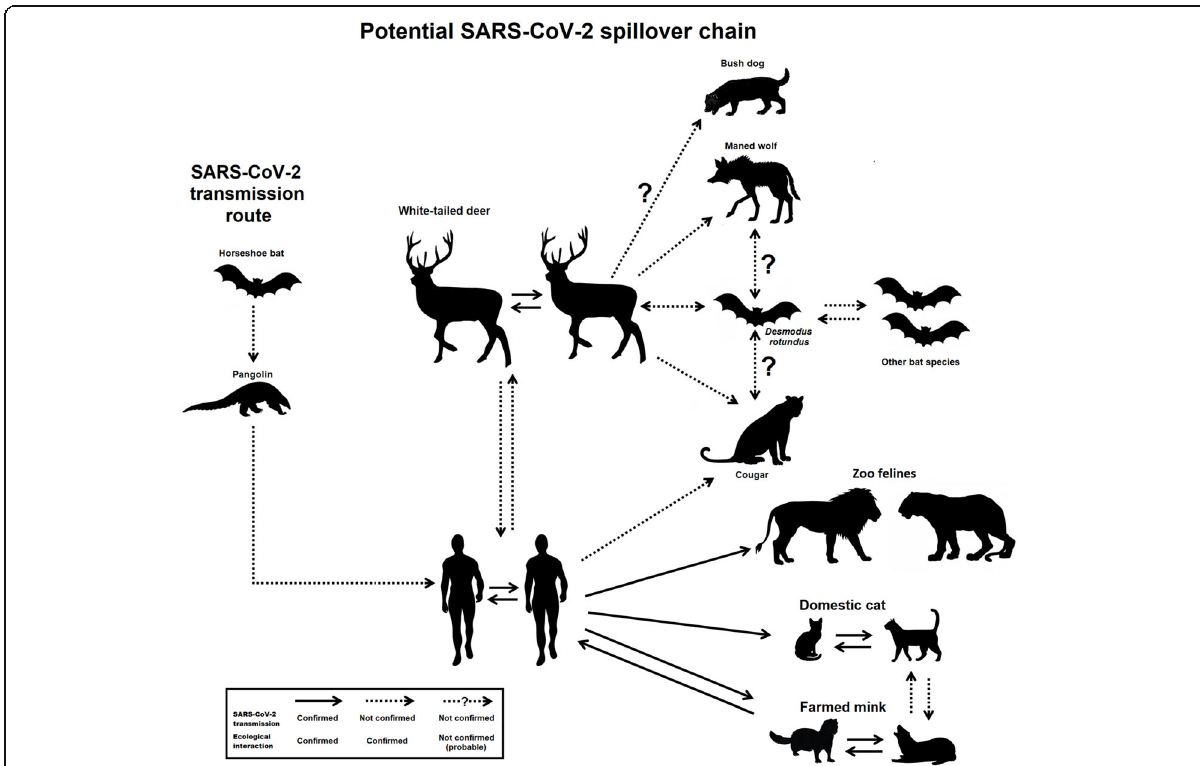
Fig. 3 Diagram displaying the potential transmission chain of severe acute respiratory syndrome coronavirus (SARS-CoV)-2 among humans and wild animals. Known SARS-CoV-2 hosts (horseshoe bat and pangolin), susceptible hosts confirmed by previous studies (white-tailed deer, mink, domestic cat, and zoo felines) and potential SARS-CoV-2 hosts (cougar, maned wolf and bush dog) predicted by bioinformatics analysis were included. (From left to right) Horseshoe bats ( Rhinolophus genus), the main animal reservoir of SARS-CoV-2 (SARS-like-CoV) and Malayan pangolin, the SARS-CoV-2 intermediate host. White-tailed deer are susceptible to SARS-CoV-2 infection and are preyed by cougars, a potential SARS-CoV-2 host predicted by this study. SARS-CoV-2 may transmit from humans to cougars, considering that lions and tigers were infected by SARS-CoV-2 in the zoo. Maned Wolf, a potential SARS-CoV-2 host, can prey on other deer species. Bush dog is likely to prey on deer, but evidence is lacking. D. rotundus , a vampire bat, is a SARS-like-CoV host that can feed on white-tailed deer and other deer species. Moreover, D. rotundus could spread coronavirus to other bat species or even to cougar, maned wolf or bush dog, although there is no scientific